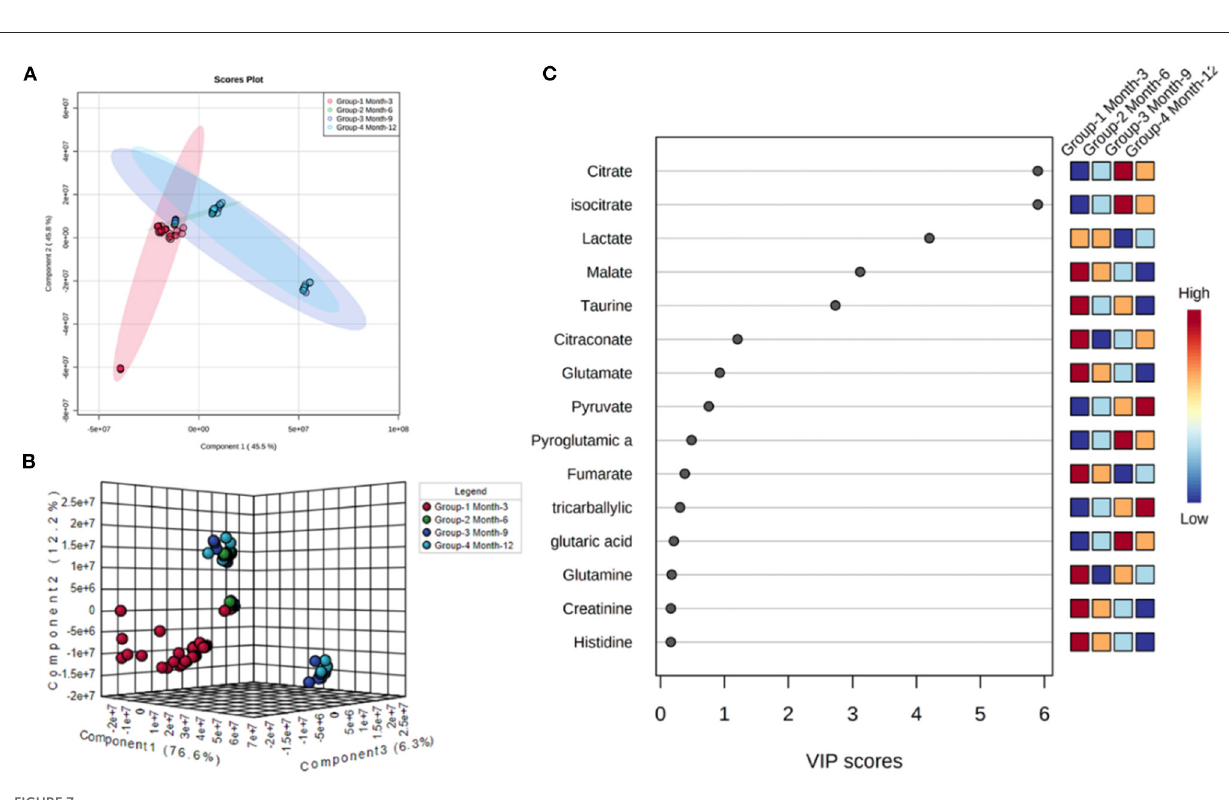
intermediates and products in glycolytic energy production. For this reason, glycolysis, the TCA cycle, and amino acid profiles were the primary focus of this